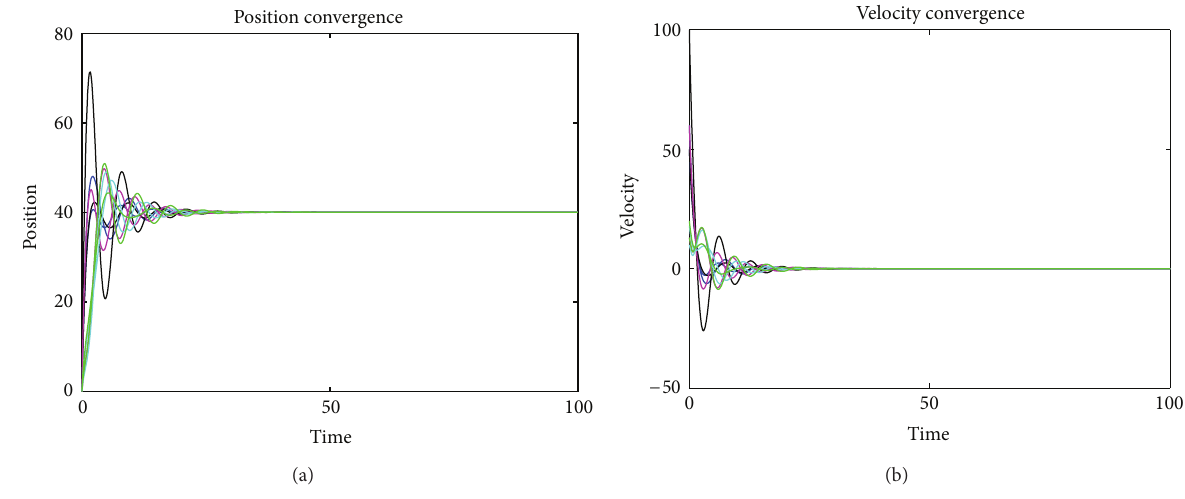
Figure 1: The consensus in system (1) with the general topology as 𝜏 = 0.5